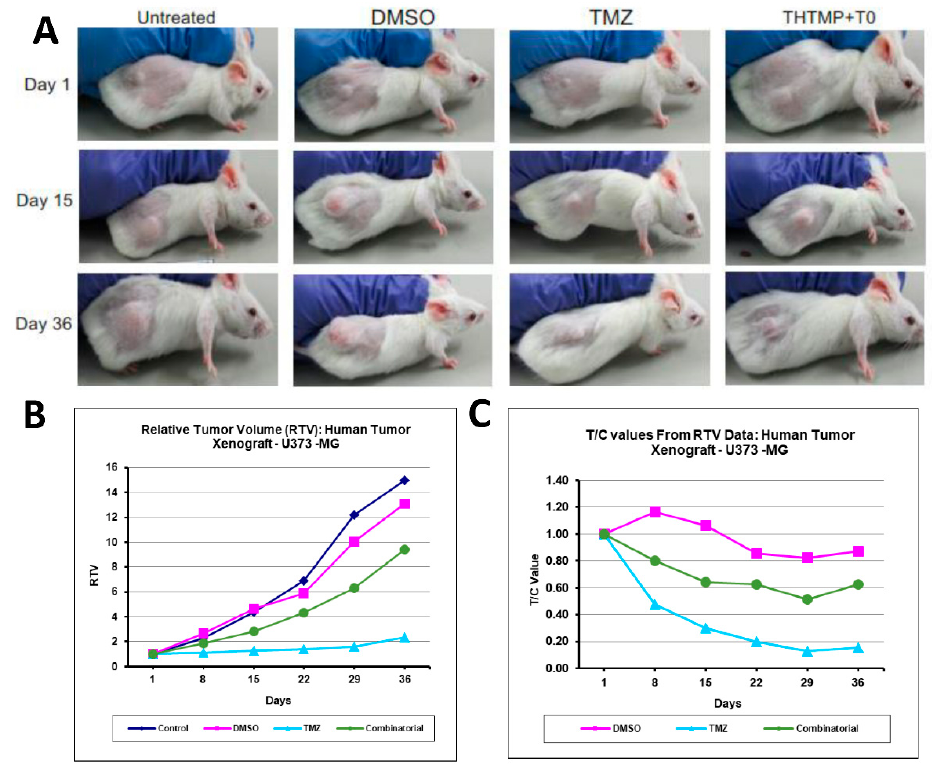
Figure 8. The anti-tumor efficacy of combinatorial treatment on glioblastoma xenograft model images of xenograft mice up to 36 days of treatment ( A ). Tumor growth curves of combinatorial treatment with TMZ as the positive control ( B ). The percentage treatment/control (T/C%) values or percent tumor regression values of combinatorial treatment and TMZ ( C ). No significant body weight change was observed after the drug treatment. RTV changes after the combinatorial treatment with p -value < 0.05 representing significant differences compared to vehicle control (DMSO) and positive control (TMZ).